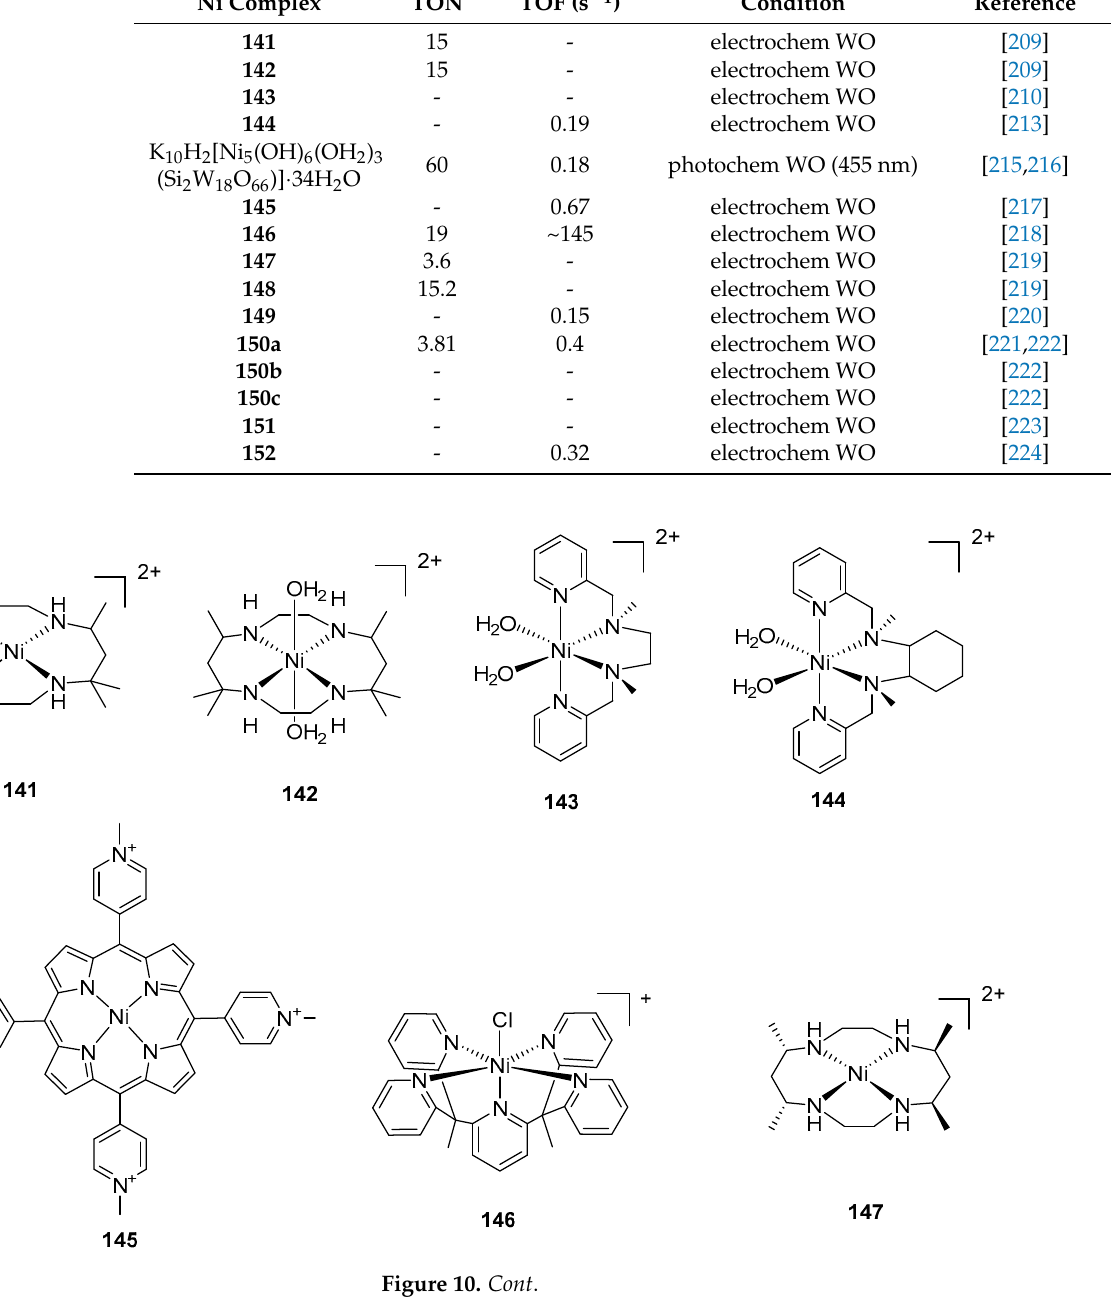
Table 9. Selected catalytic parameters and experimental conditions for nickel catalysts 141–152 for water oxidation. Electrochemical and photochemical water oxidation are abbreviated as ‘electrochem WO’ and ‘photochem WO’, respectively. The TON or TOF values that are not listed in this table are unavailable in literature. Irradiation wavelength for photochemical WO is in parentheses.